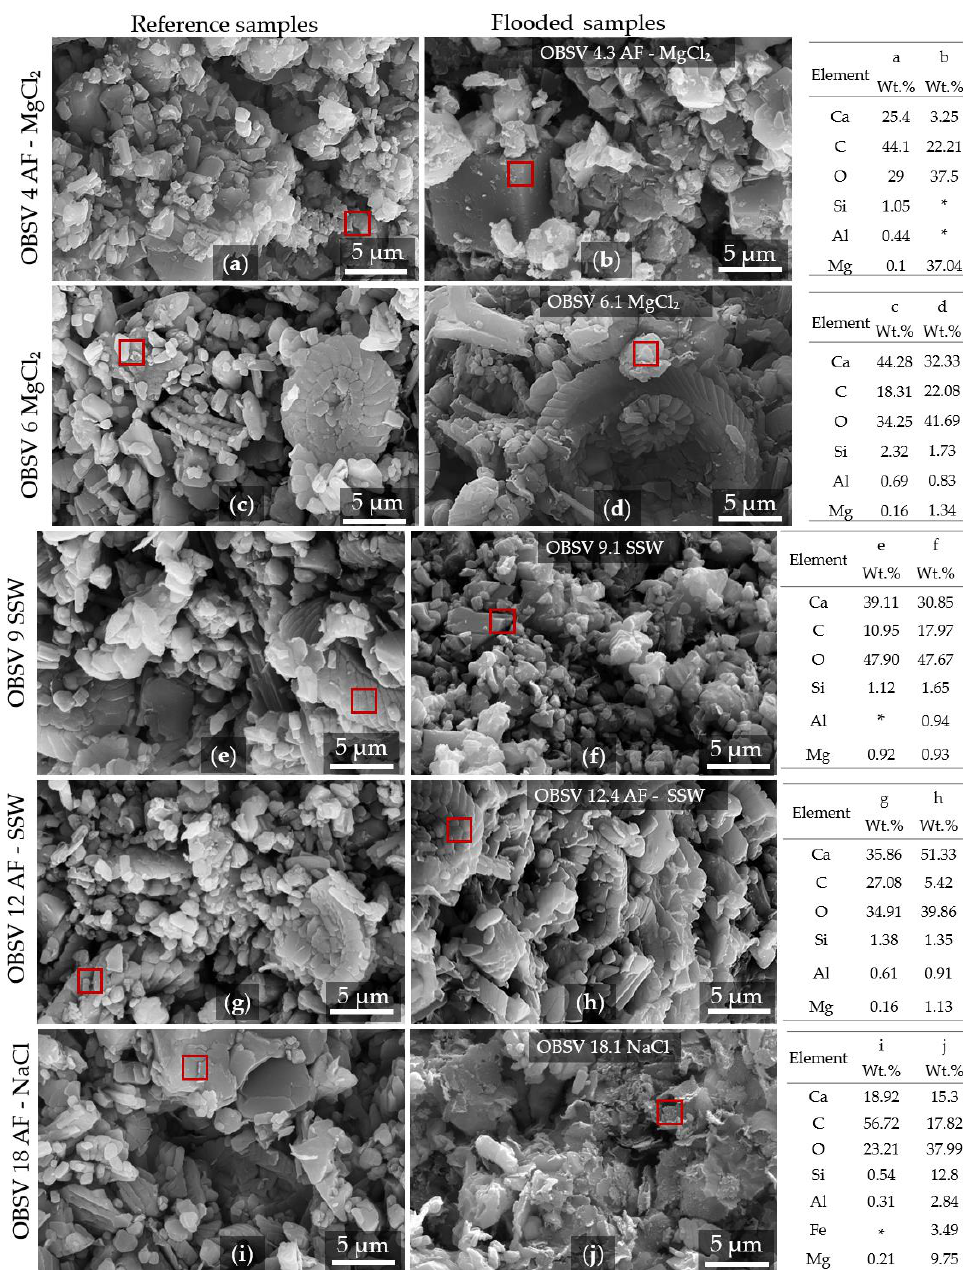
Figure 8. ( a – j ) SEM-EDS analysis highlights morphological and elemental differences between reference samples (left column) and flooded samples (right column). The artificially fractured samples were extracted from the surface of the fracture fill (Figure 6a,c). The EDS analysis was extracted from a two-time two µm area marked with a red square on each SEM image. The corresponding elemental composition is presented to the right of the images (semi-quantitative). See text for more detailed descriptions. * Element not detected